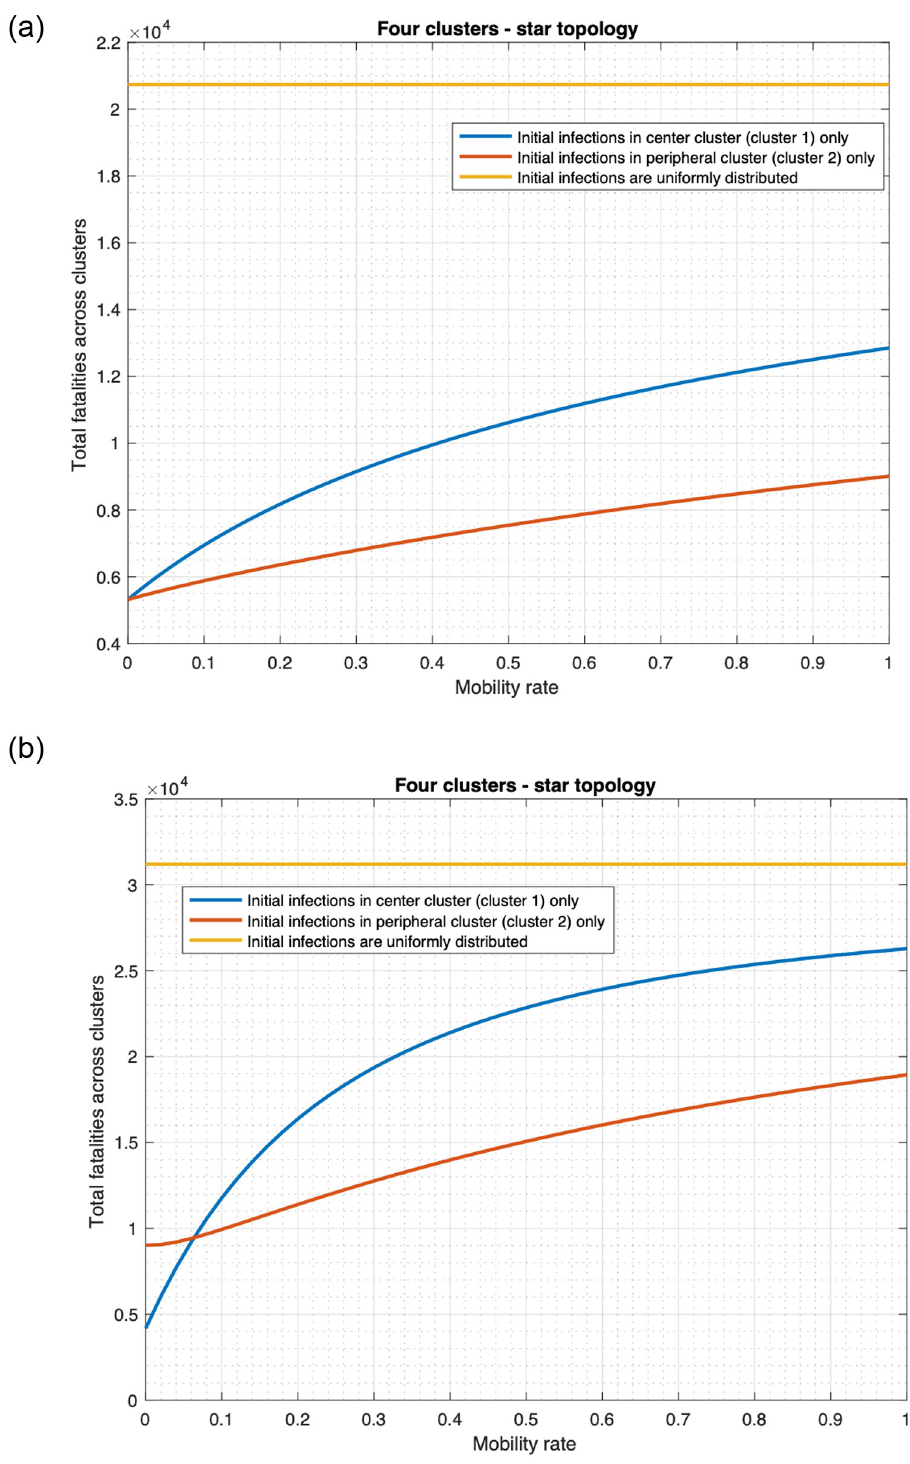
Fig 13. Relationship between fatality and initial distribution of cooperatives. (a) Initial cooperatives are uniformly distributed across clusters (initial cooperativity = 0.25). (b) Initial cooperatives are only in the central cluster (initial cooperativity =